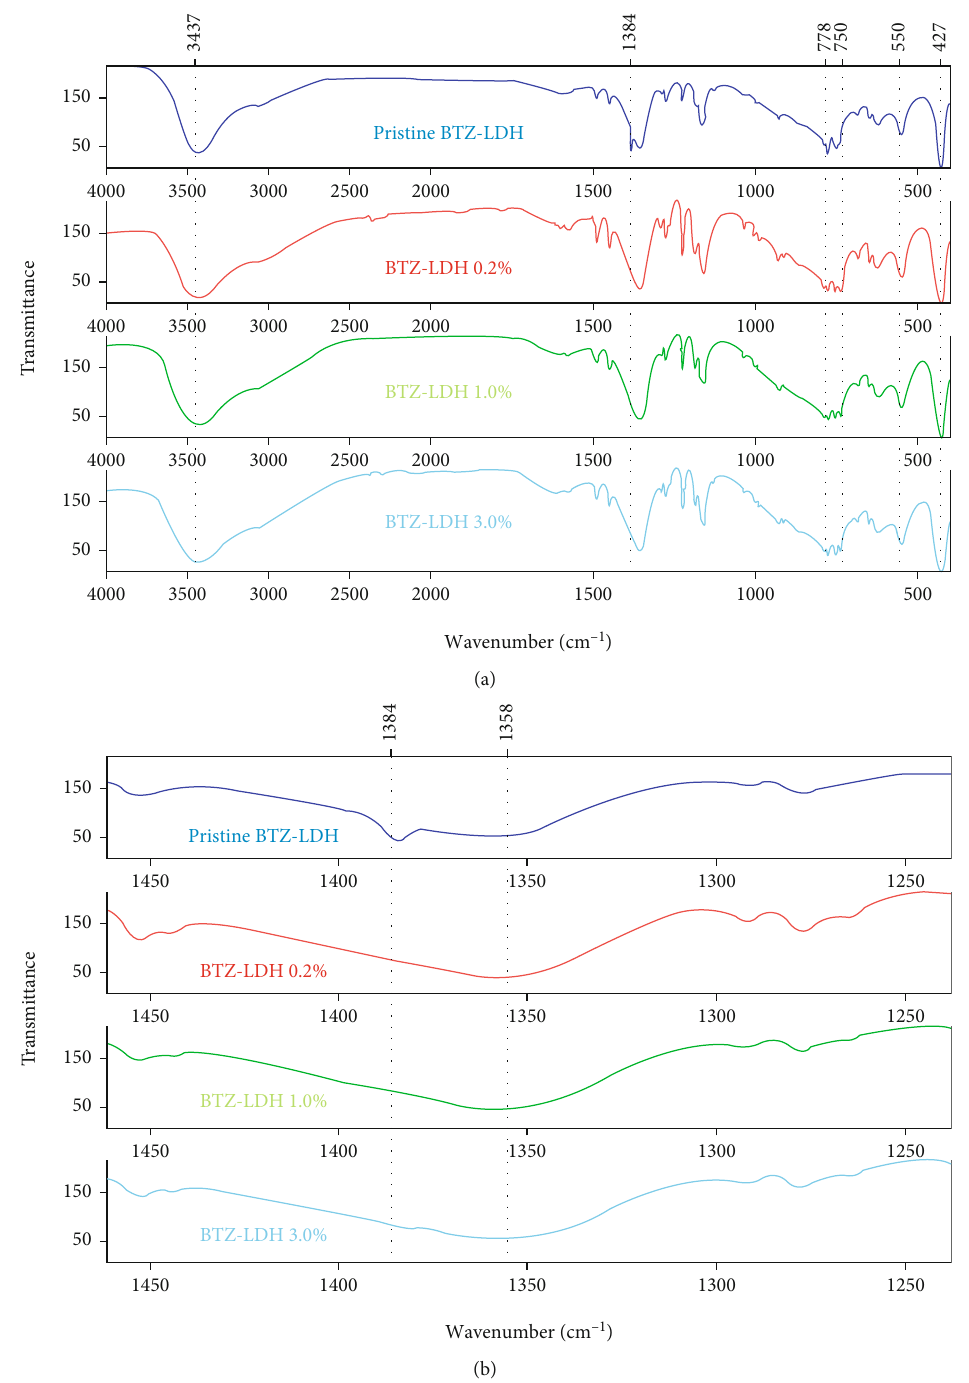
Figure 3: Comparative spectra of BTZ-LDH before and after exposure to 3.5% NaCl (a) spectrum in full and (b) zoom in the 1384 cm -1